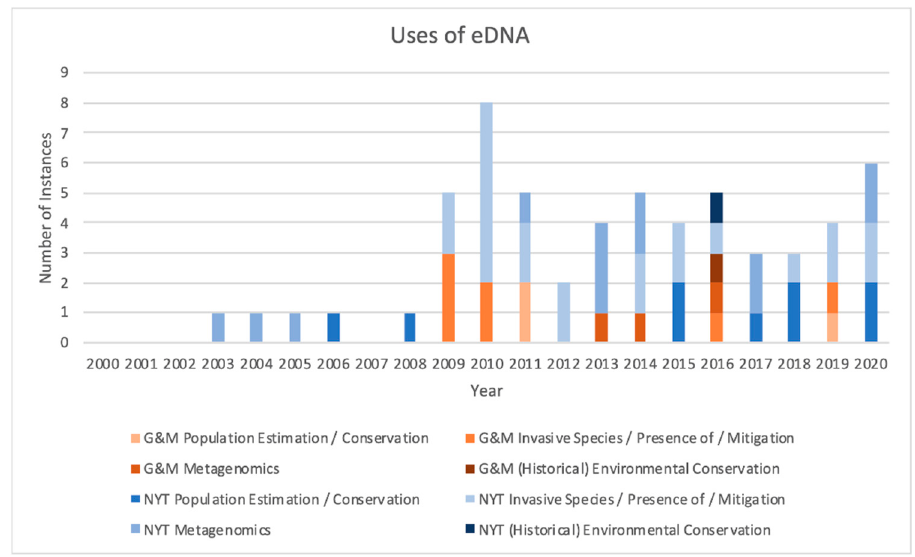
Figure 3. Uses of eDNA reported in the G&M and NYT , 2000–2020.